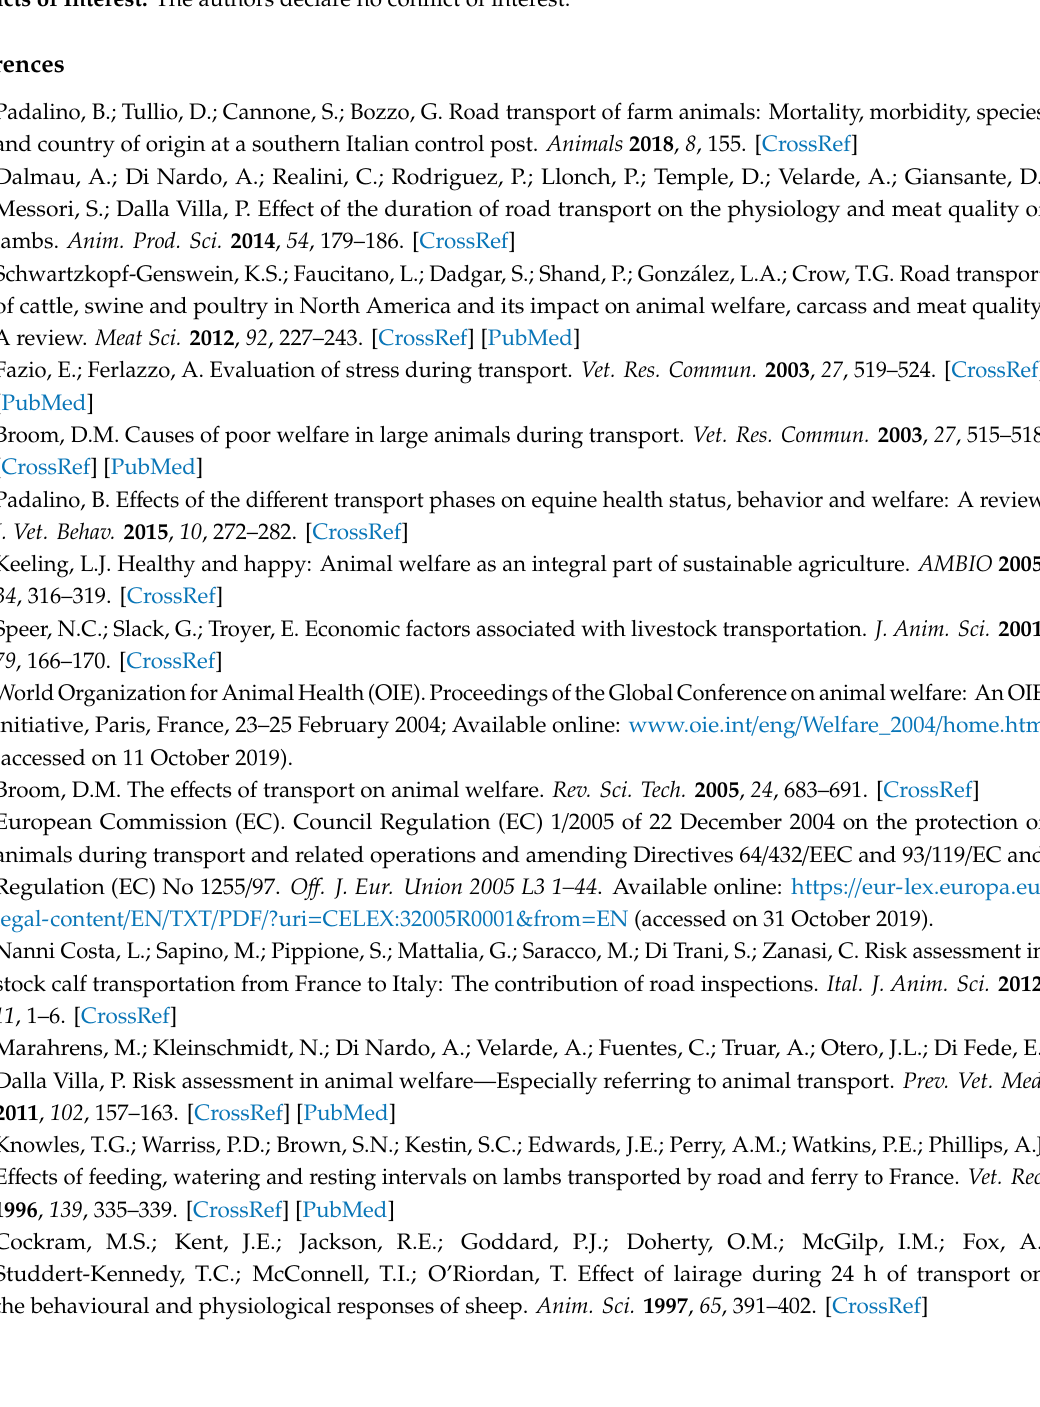
Figure S1: The percentage of total variance explained by the first ten dimensions identified by the Multiple Correspondence Analysis. Table S1: The contribution of the variable categories (in %) to the definition of the dimensions of the Multiple Correspondence